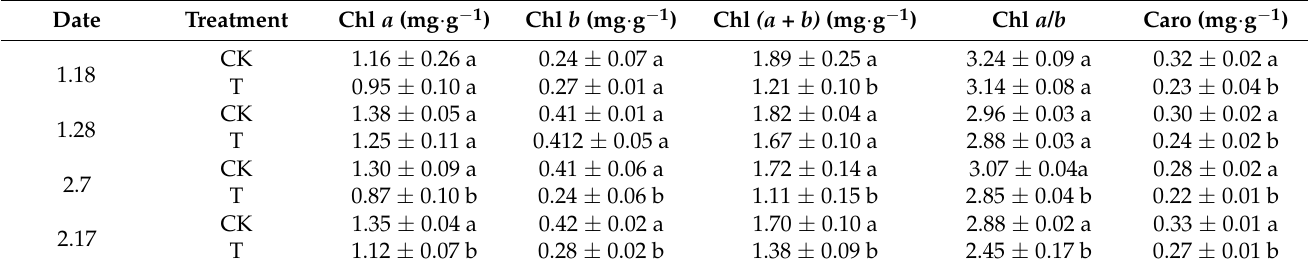
Table 2. The effect of enhanced UV − B radiation (T) on the chlorophyll content in leaves.